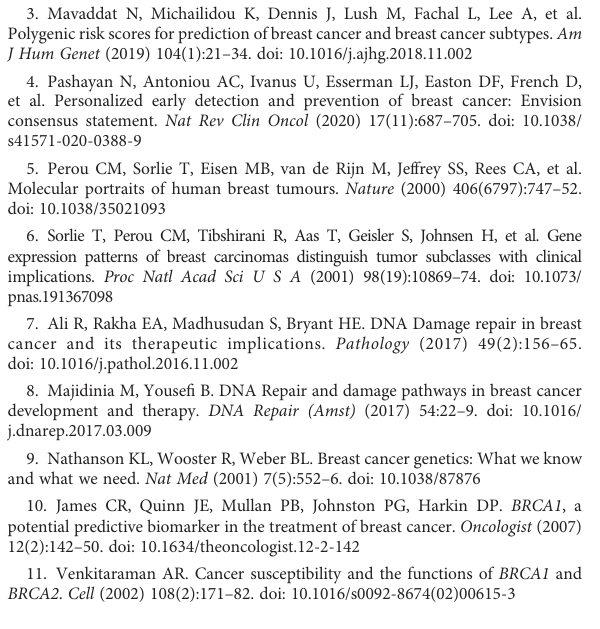
SUPPLEMENTARY FIGURE 2 Box plot for displaying relationship between prognostic DNA repair genes or risk score and clinical features. (A) Gender; (B) Race; (C) Age; (D) Estrogen receptor; (E) Progesterone receptor; (F) HER2 receptor; (G) Stage; (H) T stage; (I) M stage; (J) N stage. SUPPLEMENTARY FIGURE 3 The evaluated half maximal inhibitory concentration (IC50) for each of 16 anti-cancer drugs between high-risk group and low risk group were displayed in box plots. (A) Bexarotene; (B) Camptothecin; (C) Cisplatin; (D) Docetaxel; (E) Etoposide; (F) Gemcitabine; (G) Imatinib; (H) Methotrexate; (I) Paclitaxel; (J) Rapamycin; (K) Vinorelbine; (L) Vorinostat; Each dot stands for the estimated IC50 value of corresponding drug in breast cancer sample. The higher IC50 is the less sensitive breast cancer is to this drug.